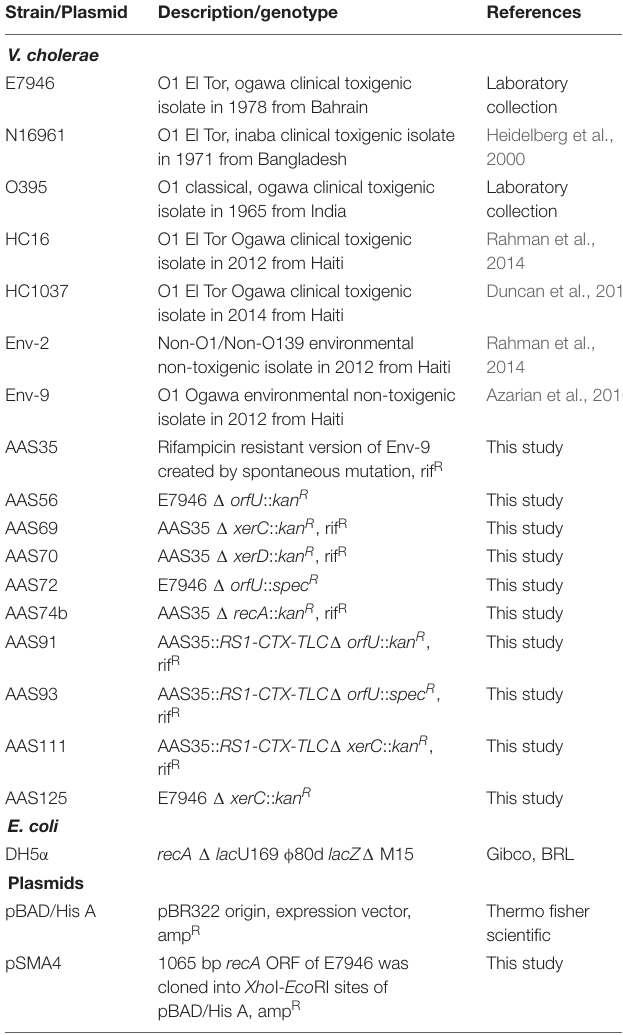
TABLE 1 | Bacterial strains and plasmids used in this